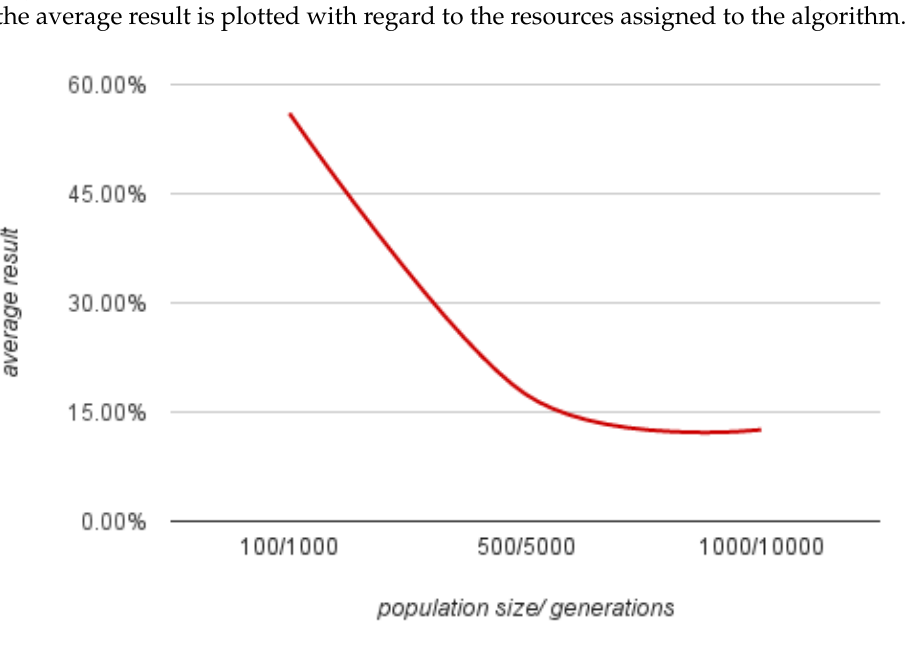
Figure 10. Crossover domination experiment—average result of iterations and population